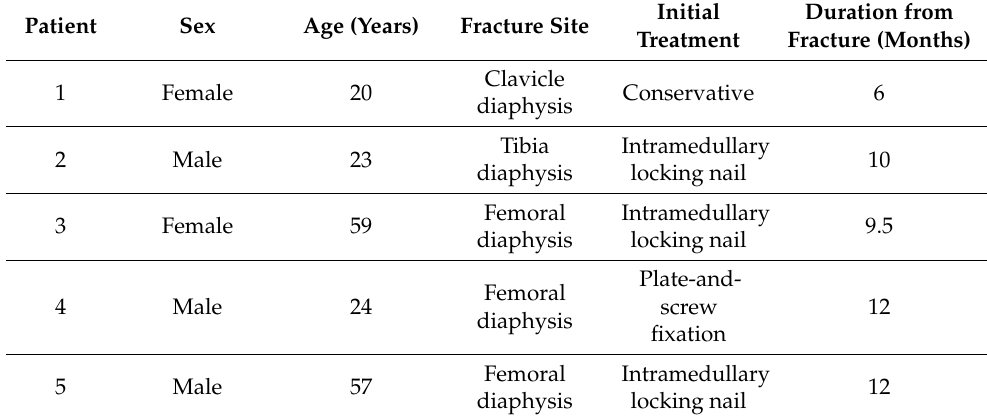
Table 1. Cell sample data of the study